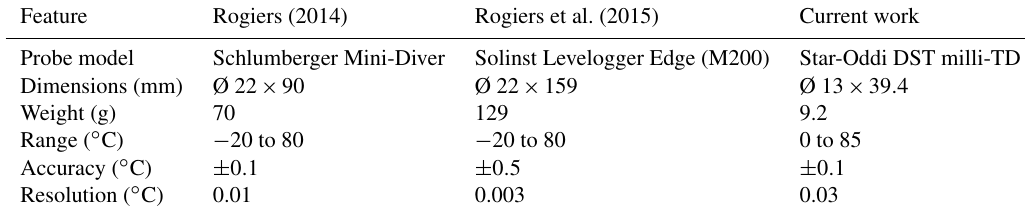
Table 2. Summary of temperature sensors used for different